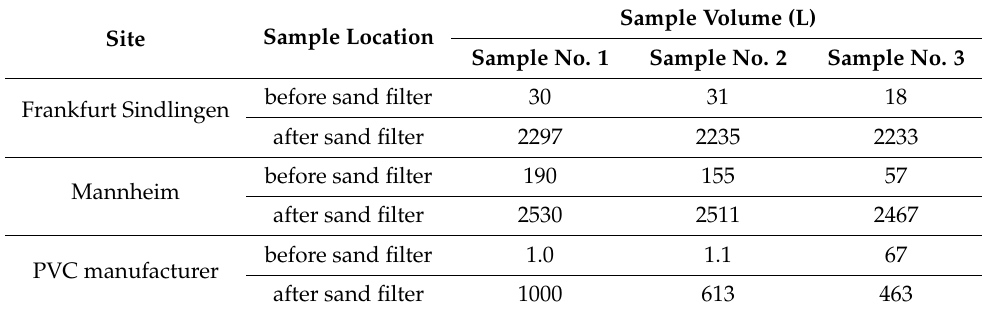
Figure 1. Flow diagram of an exemplary municipal wastewater treatment plant (WWTP) with a downstream sand filter and the respective sampling locations (before and after sand filter—1 and 2). Table 1. Exact volumes of collected samples at each